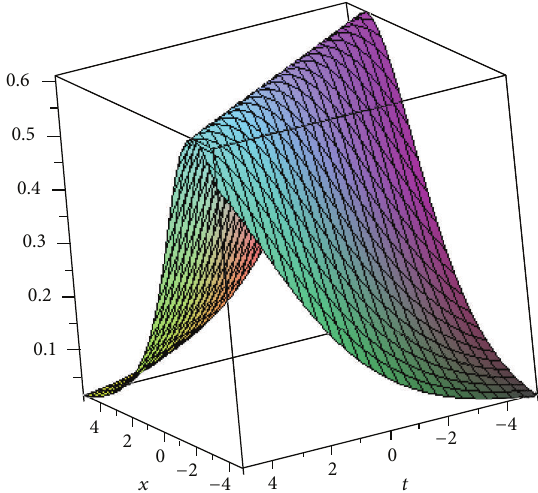
Figure 3: The plot of solution (30) with 𝛽 = 𝑅 = 1 , 𝜇 = 𝑛 = 2 , and 𝛾 = −1